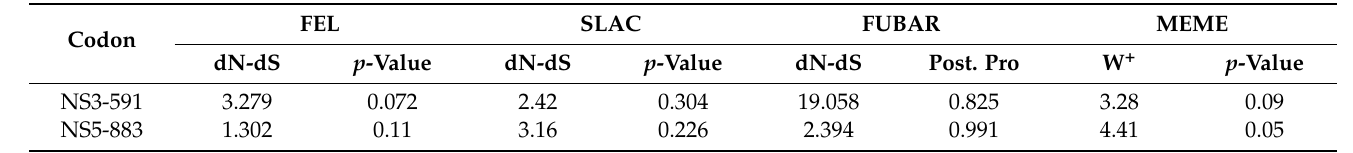
Figure 6. The relationship of TMUV was deduced using the E genes of the different flaviviruses. The BI tree was reconstructed using Mrbayes. The different flavivirus are expressed by different RGB colors, as indicated. The RGB color numbers are FF6666, 6666FF, 009999, FF00CC, FF003C, and 999900, for Quang Binh virus, mosquito flavivirus, Zika virus, Dengue virus, West Nile virus, and Tembusu virus, respectively. Table 1. The selection analysis of NS3 and NS5 sequences of